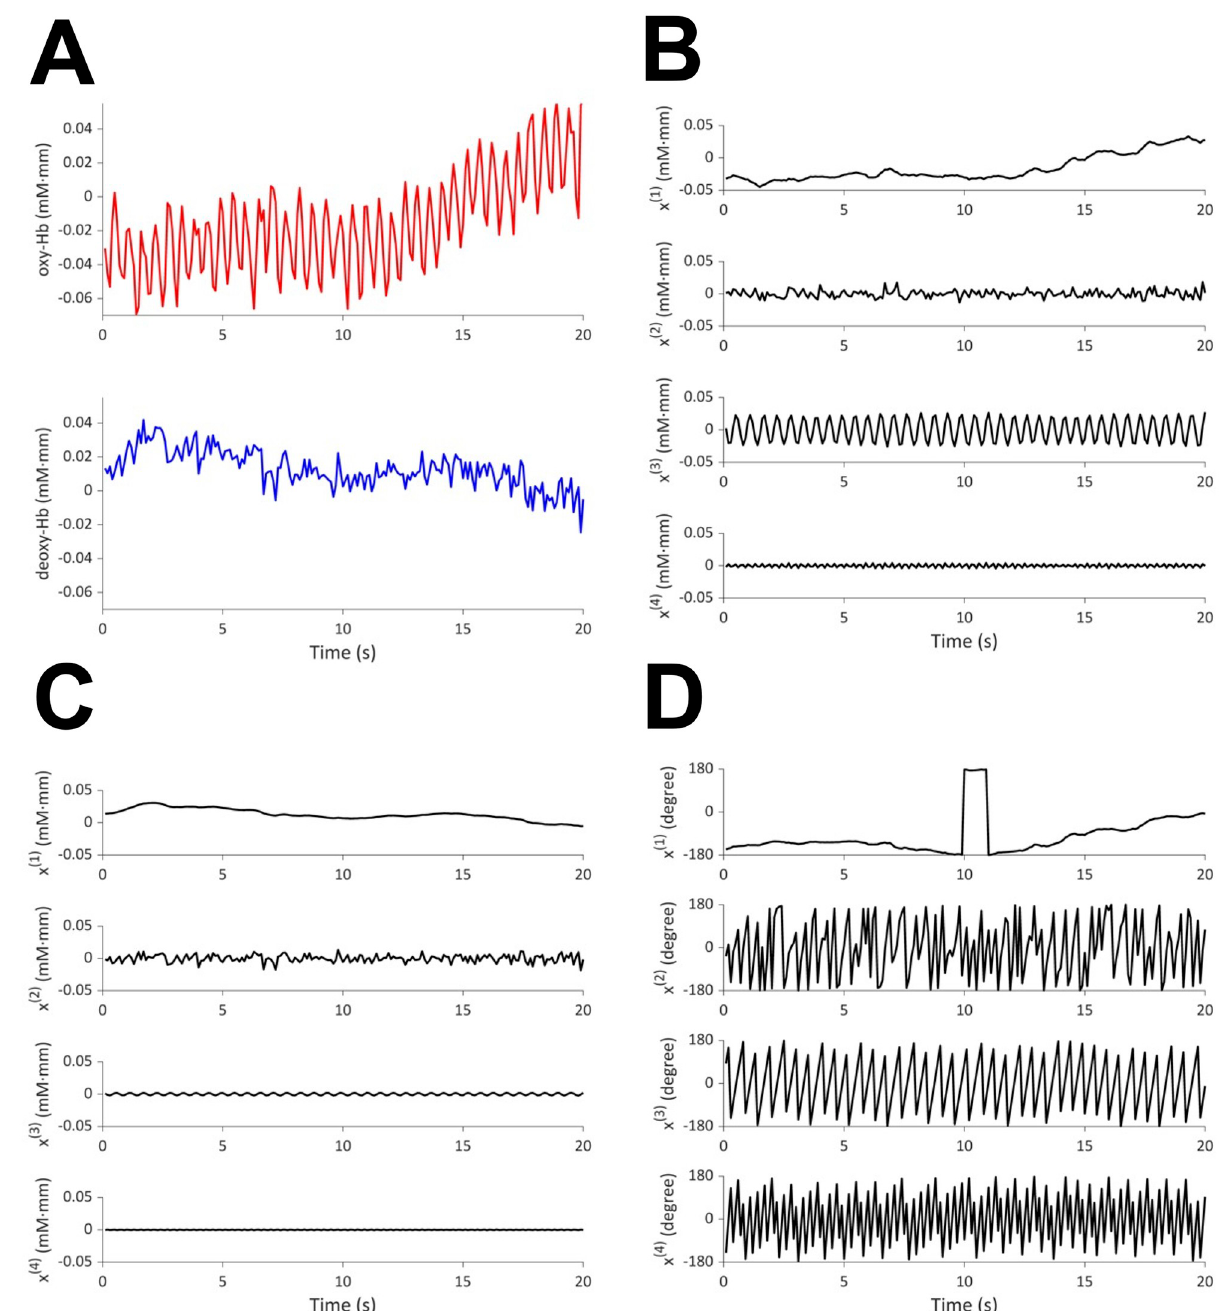
Fig 7. (A) Infant fNIRS (20 seconds). Red: oxy-Hb; blue: deoxy-Hb. (B) Four oscillation components in oxy-Hb. (C) Four oscillation components in deoxy-Hb. (D) Phase of the extracted